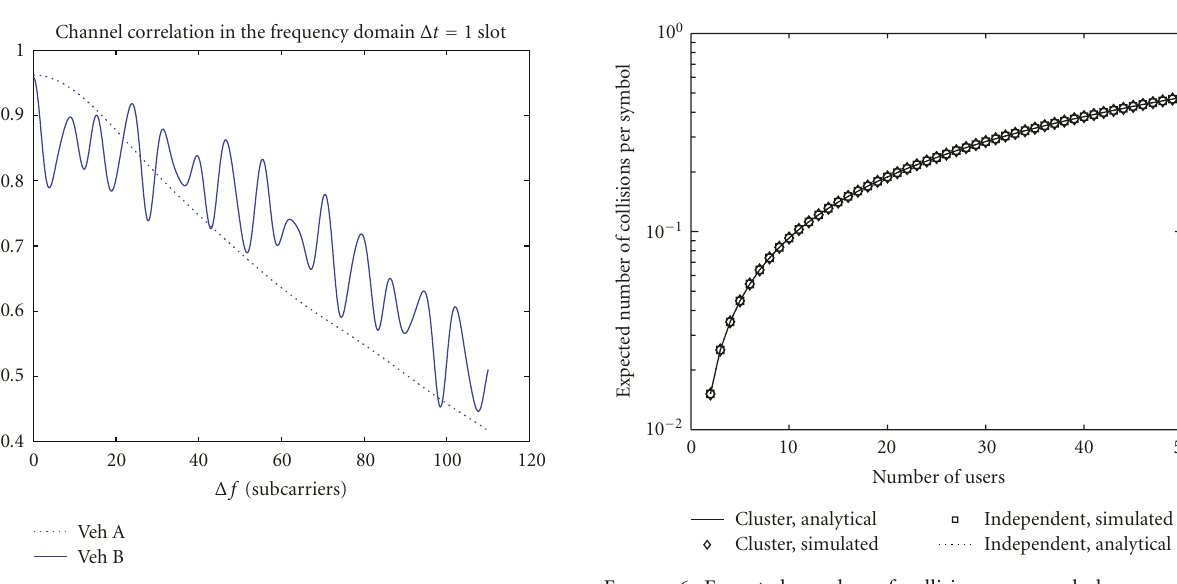
Figure 5: Channel correlation function. Table 1: System parameters.